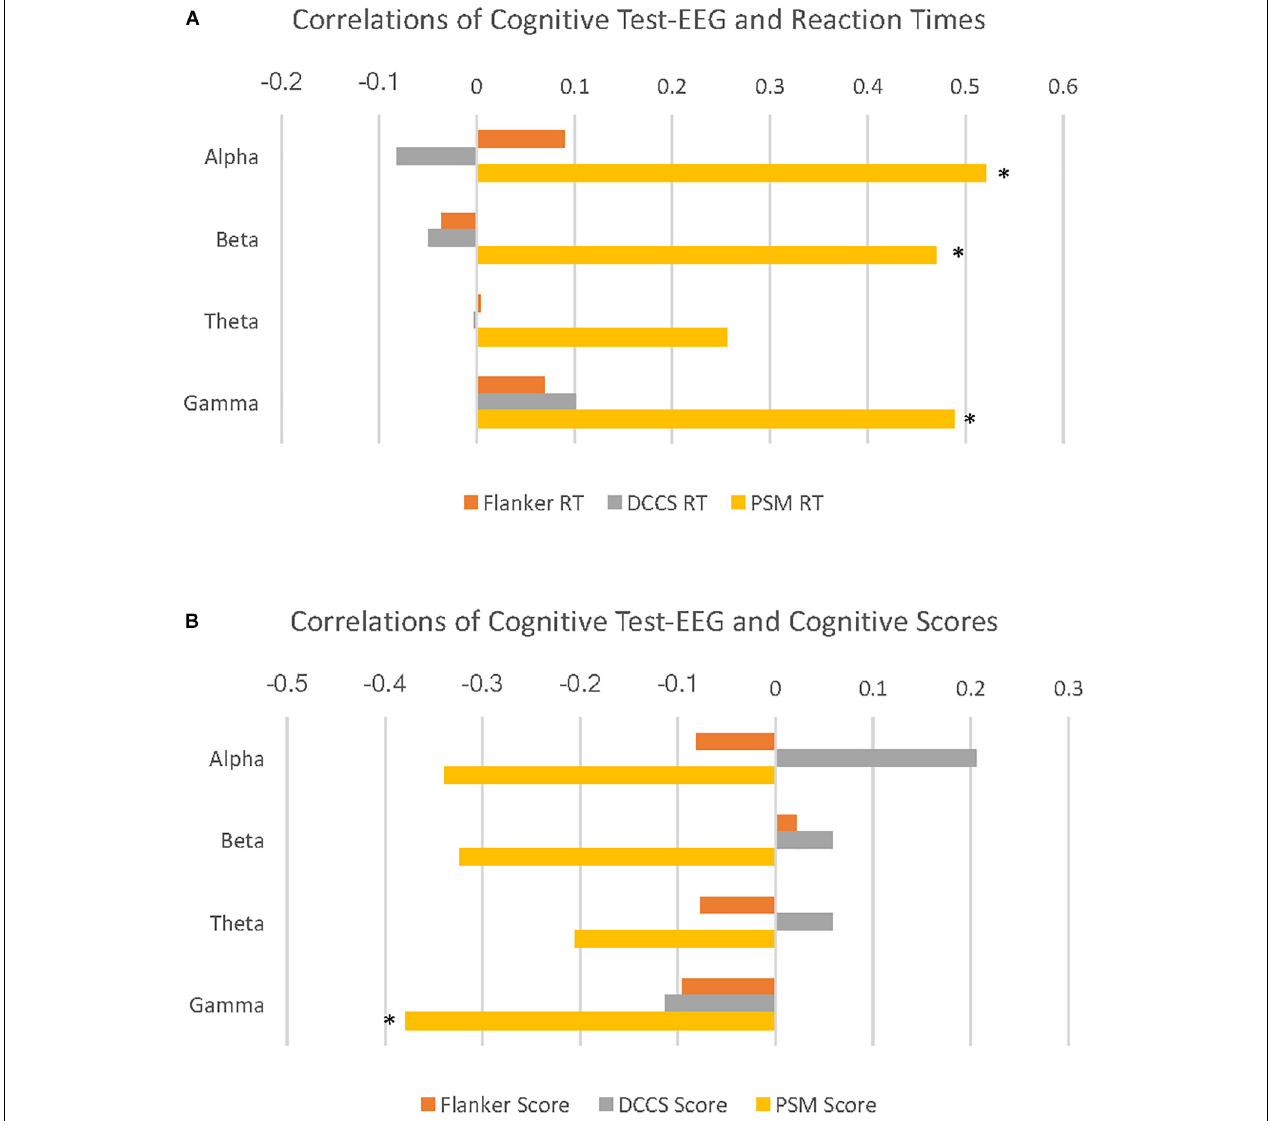
FIGURE 2 | Cognitive test-EEG correlations with reaction times and age-corrected standard scores on the cognitive tests. (A) horizontal bar graphs illustrate correlations of PSD for 4 EEG frequency bands with reaction times (RT) during 3 cognitive tests. Here, alpha, beta and gamma EEG PSD activity are all significantly positively correlated with Picture Sequence Memory (PSM) RT. (B) horizontal bar graphs illustrate correlations of 4 EEG frequency band PSD with age-corrected standard scores (cognitive scores) during 3 cognitive tests. Here, gamma activity is significantly negatively correlated with PSM scores. ( ∗ p < 0.05).